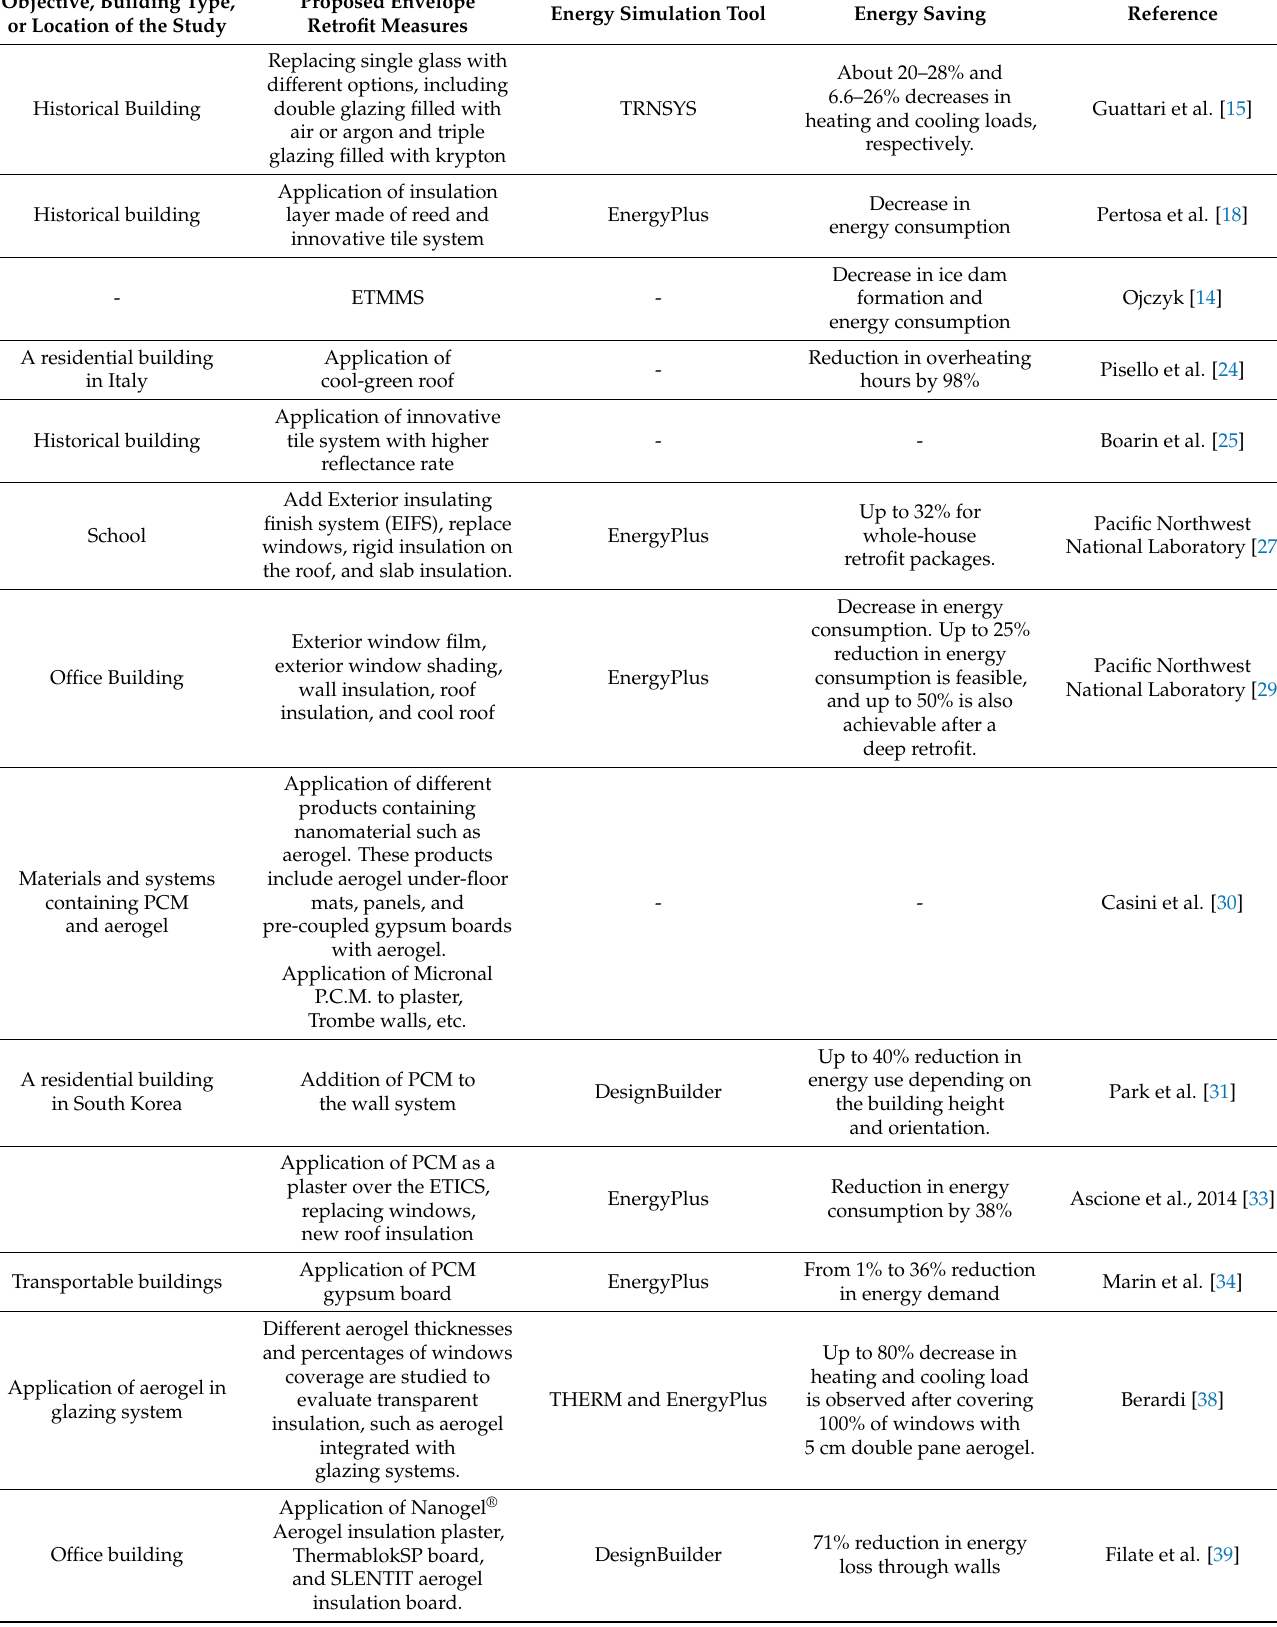
Table 5. Summary of the energy retrofit methods used in the building